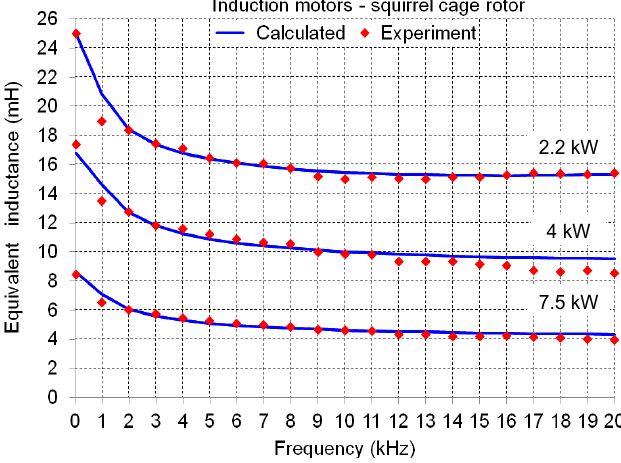
Figure 5. Model and experimental results for L eq vs supply frequency for three squirrel-cage IMs.